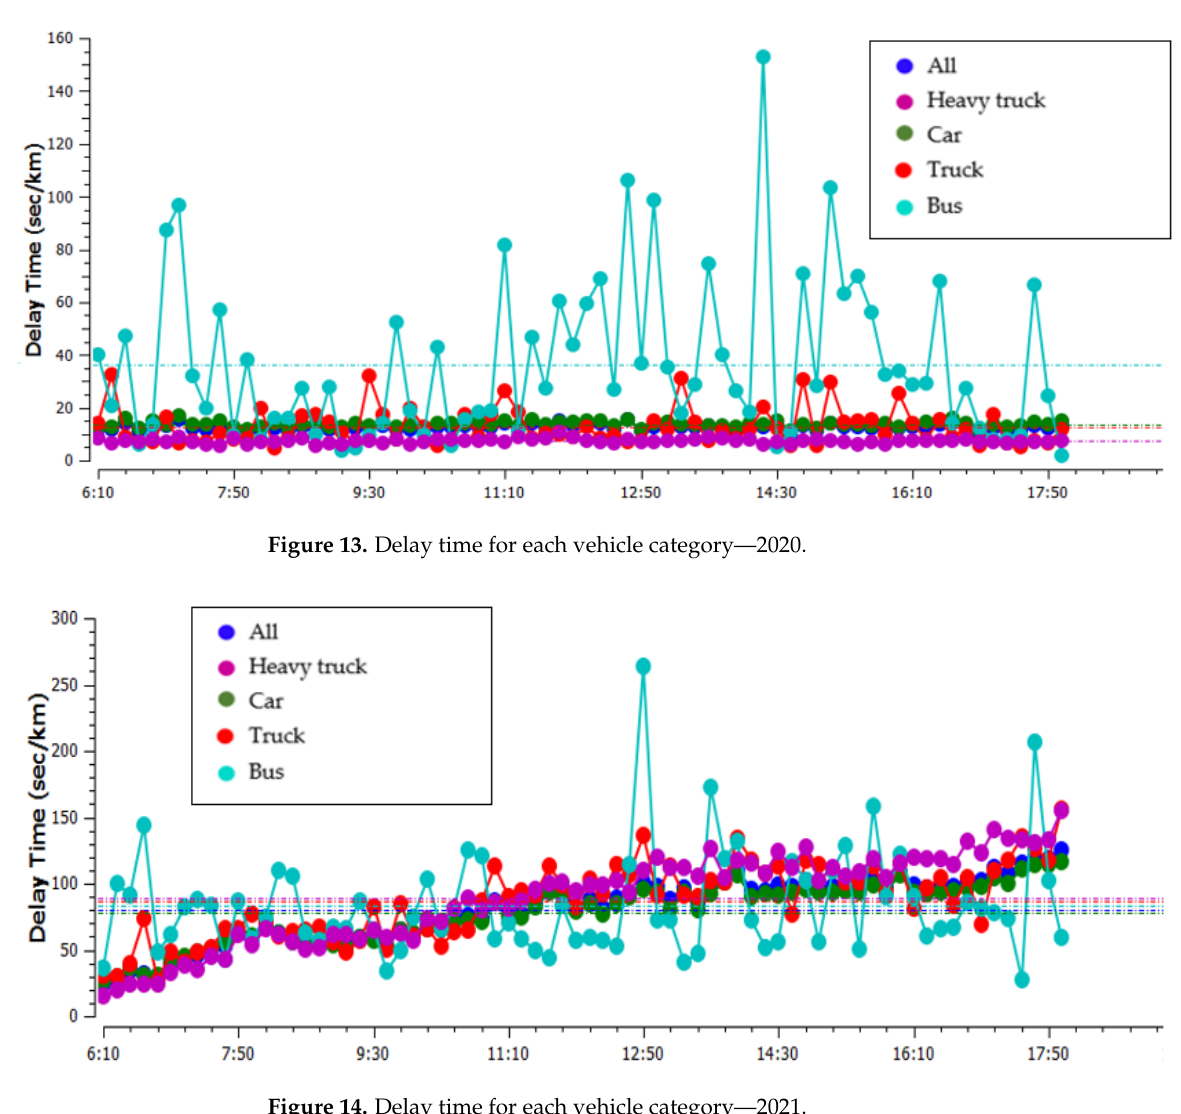
Figure 12. Delay time for each vehicle category—2019.